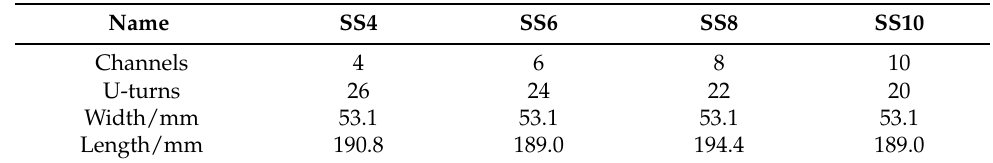
Table 7. Separate serpentine configurations for a geometric area of 100cm 2 with a channel width of